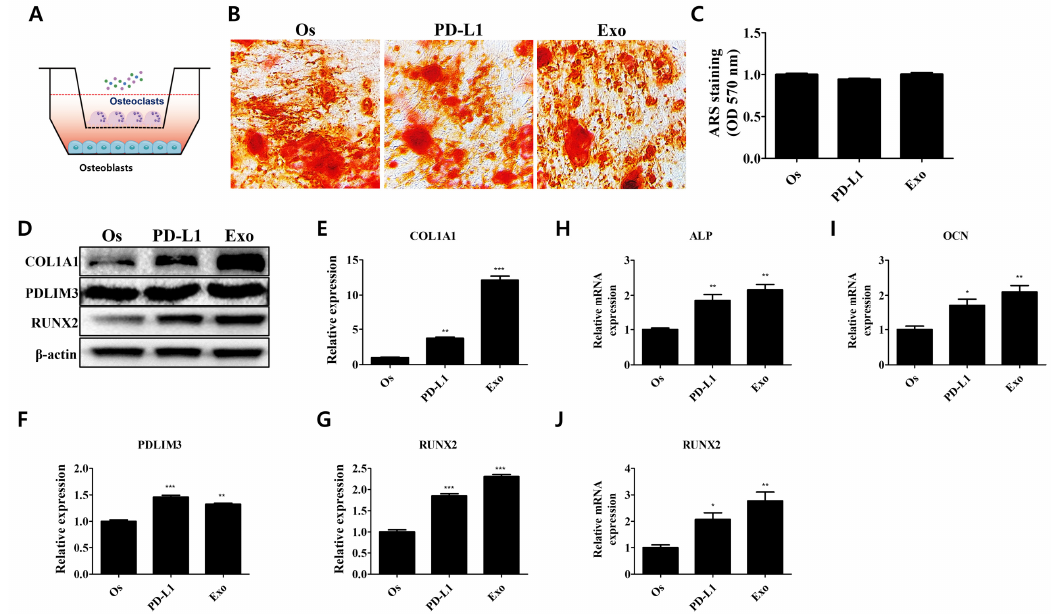
Figure 6. Modulatory effect of exosomal PD-L1 on bone matrix formation in cocultured environment. ( A ) Osteoblasts and osteoclasts were cocultured to mimic the bone metabolism under physi- ological conditions. ( B ) Maintenance of the bone homeostasis in PD-L1- and exosome-treated cocul- tured osteoblasts. ( C ) Stained calcium deposits were dissolved and quantified. N = 5 trials per sam- ple and control. ( D ) Expression levels of proteins mediating the osteogenic properties upon PD-L1 and exosome treatment in cocultured osteoblasts. Relative expression levels of ( E ) COL1A1, ( F ) PDLIM3, and ( G ) RUNX2. N = 3 trials per sample and control. Relative mRNA expressions of oste- ogenic markers ( H ) ALP , ( I ) OCN , and ( J ) RUNX2 . N = 3 trials per sample and control. Data are presented as mean ± SEM. * p < 0.05, ** p < 0.01, and *** p < 0.001, compared with the Os group. Os: osteoblasts (cocultured); PD-L1: PD-L1 (500 ng/mL); Exo: exosome (10 μ g/mL, 2.5 × 10 8 parti- cles/mL).